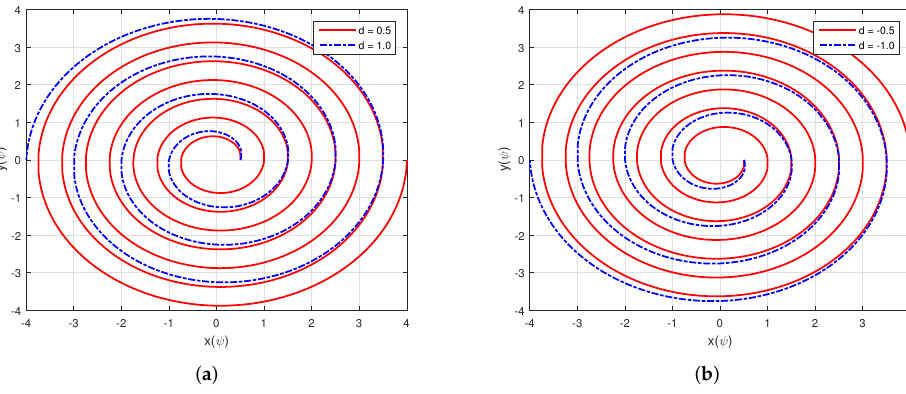
Figure 9. Archimedean spiral with various values of d : ( a ) Archimedean spiral with positive d values and ( b ) Archimedean spiral with negative d values.